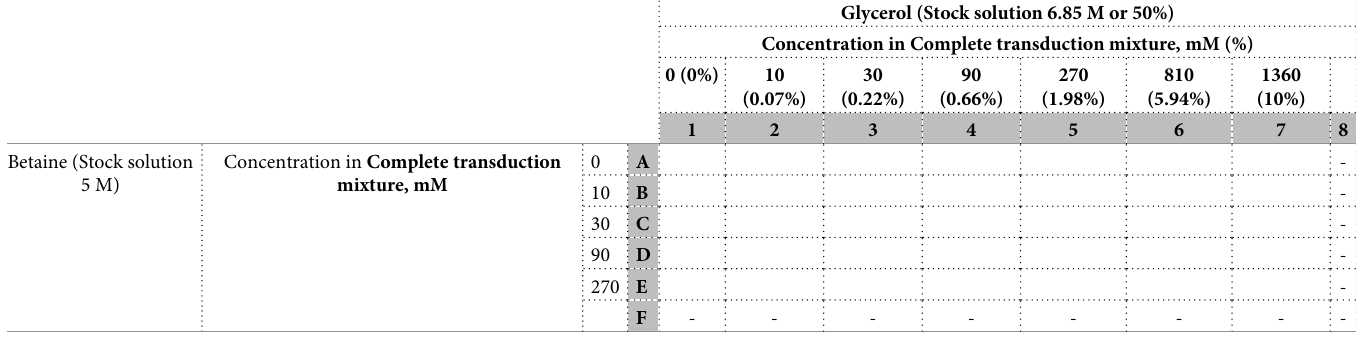
Row “F” and column #8 will be filled with PBS.